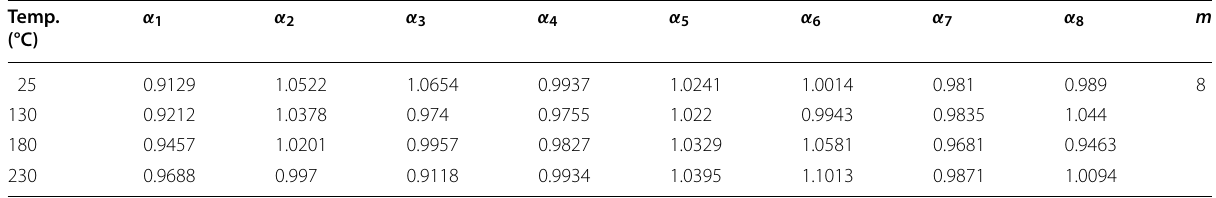
Table 5 Identified parameters in the Yld2000-2d yield function with an exponent of 8 α Temp. (°C)